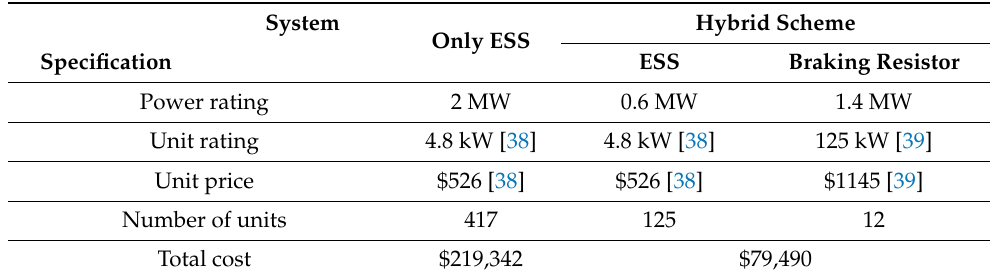
Table 1. Cost comparison of the ESS only and hybrid